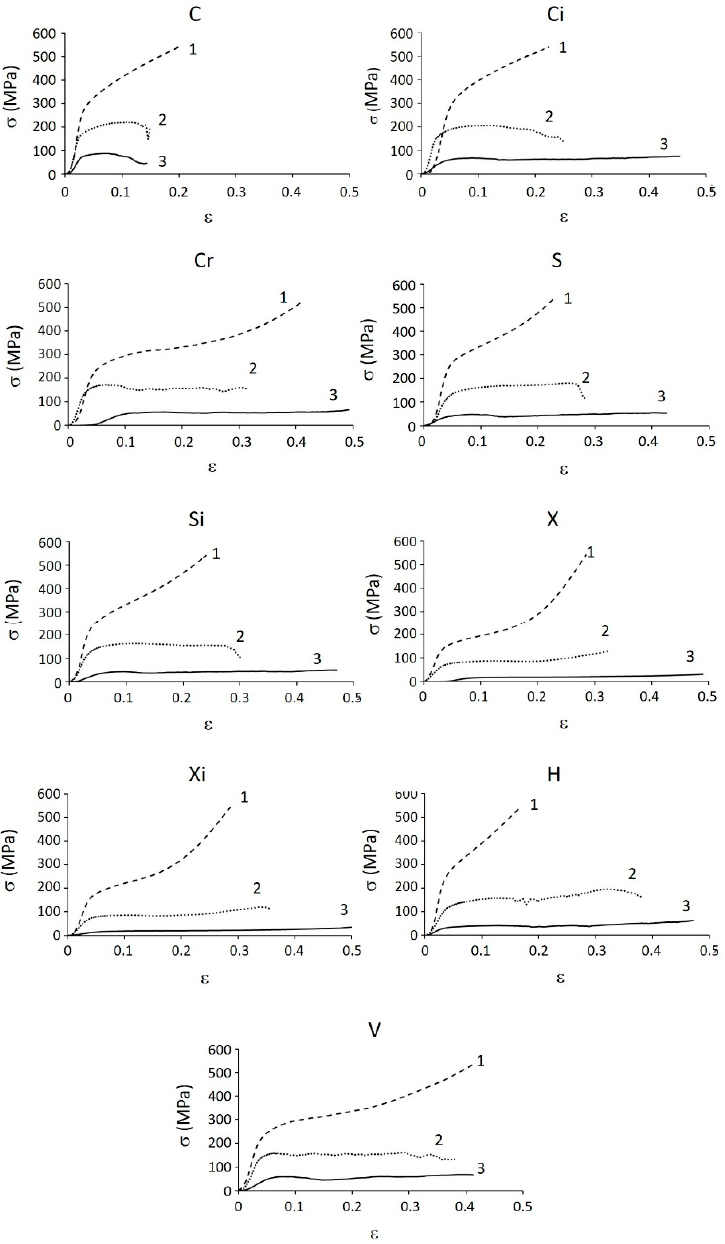
Figure 7. Examples of the compression nominal stress–nominal strain curves. Numbers refer to batches: 1—highest density; 2—intermediate density; 3—lowest